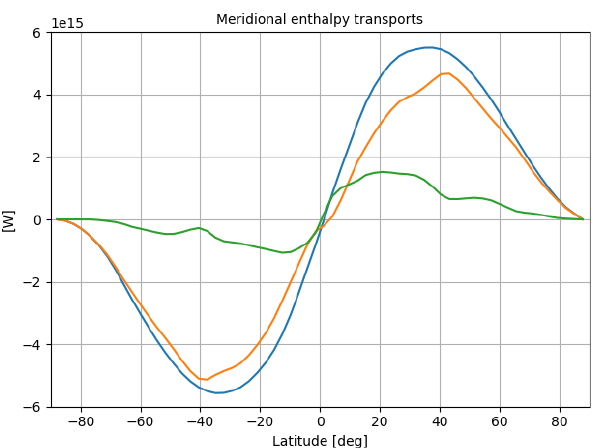
Figure 2. Climatological annual mean total (blue), atmospheric (or- ange) and oceanic (green) northward meridional enthalpy transports for 20 years of a pre-industrial CanESM2 model run